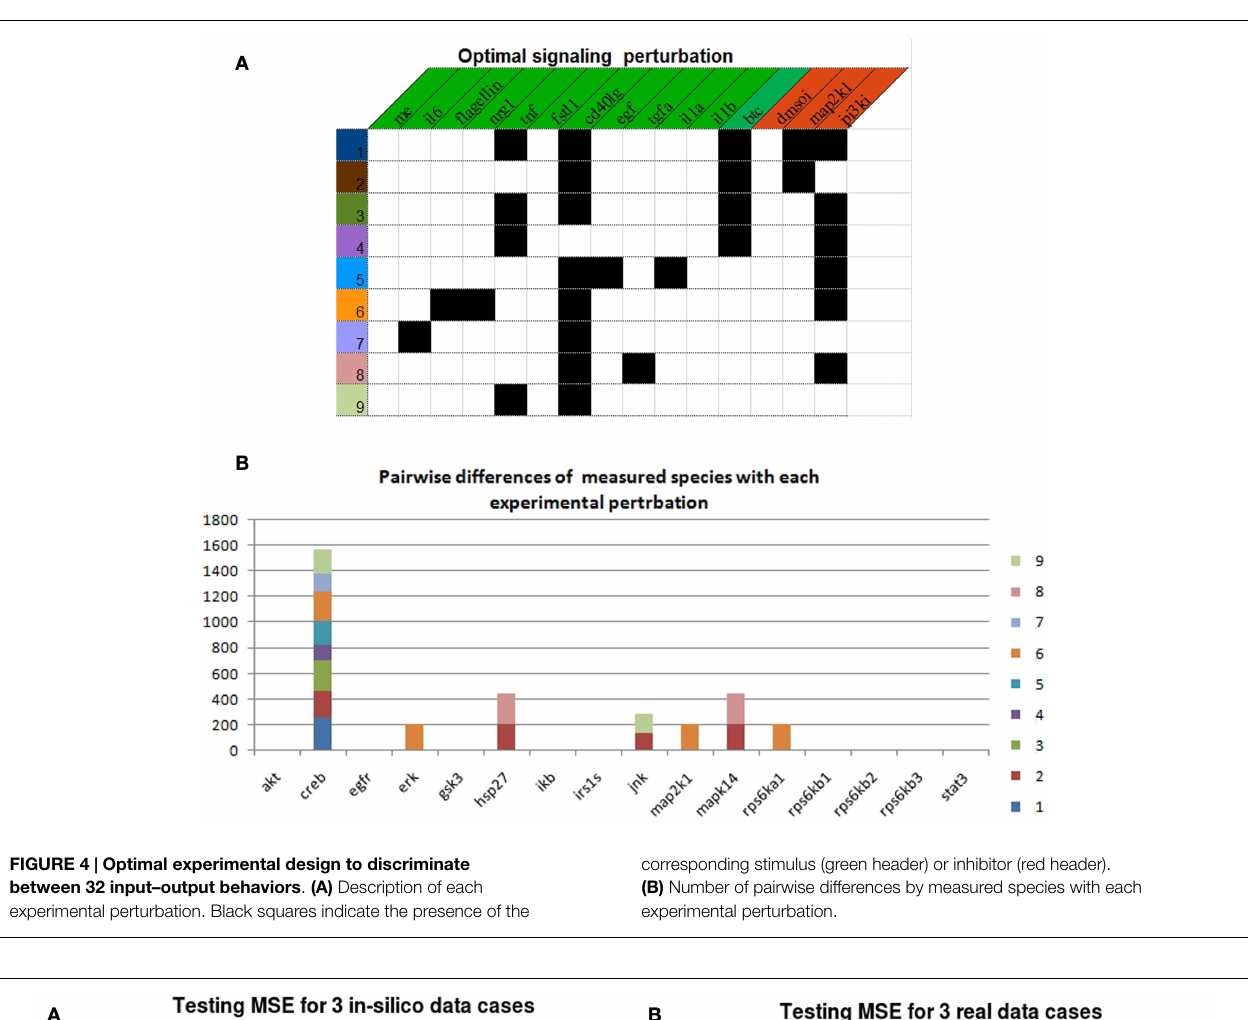
FIGURE 4 | Optimal experimental design to discriminate between 32 input–output behaviors . (A) Description of each experimental perturbation. Black squares indicate the presence of the